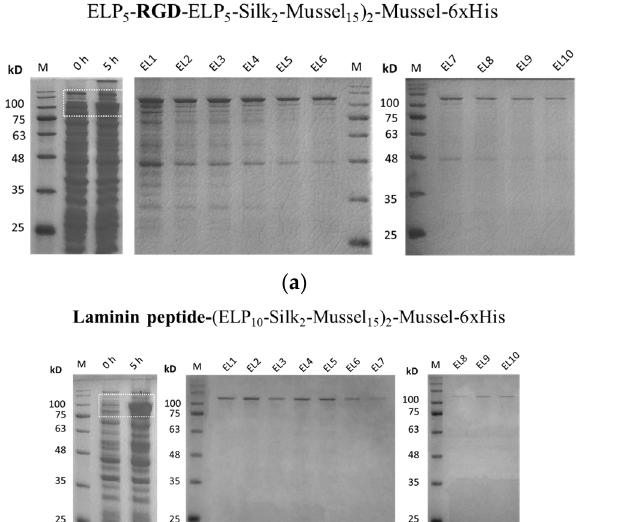
Figure 1. Step-by-step synthesis of recombinamer genes. ( a – c ) Electrophoresis in 1% w / v agarose gels of the recombinant plasmids containing building block sequences after digestion with NdeI and XhoI ( a , b ) or BseRI ( c ). In ( c ), lane 1 corresponds to digested pET29c-BMP2 peptide, and lanes pET29c-heparin-binding peptide.